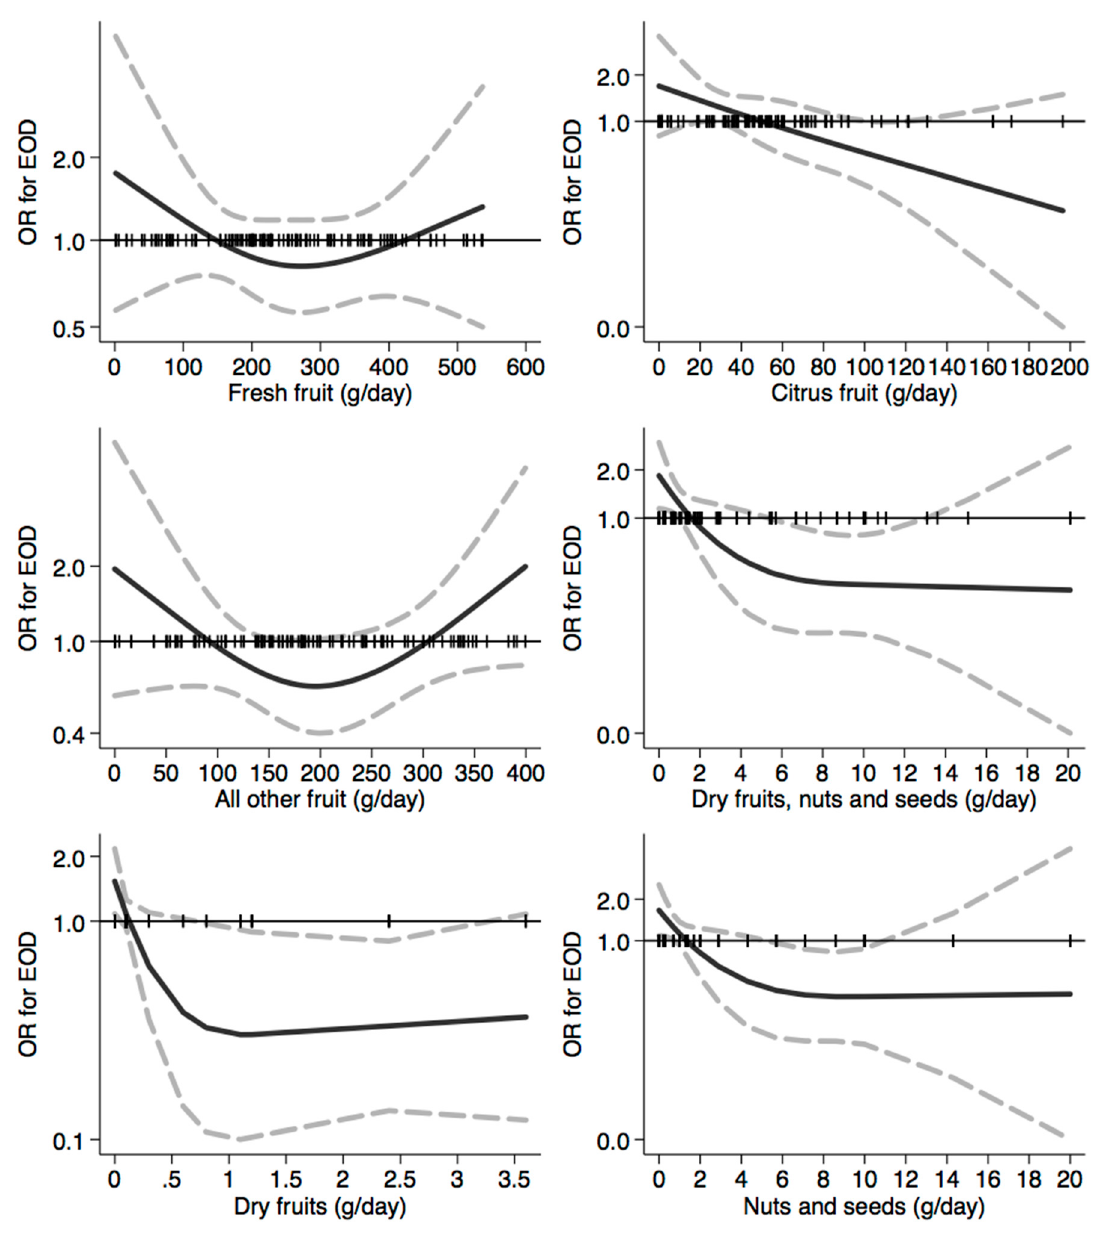
Figure 7. Spline regression analysis of early-onset dementia (EOD) risk for increasing intake of fresh and dry fruits. The black line indicates odds ratios for dementia risk; dash gray lines are 95% confidence limits; the reference line at 1.0 with black spikes indicates the distribution of participant intake.